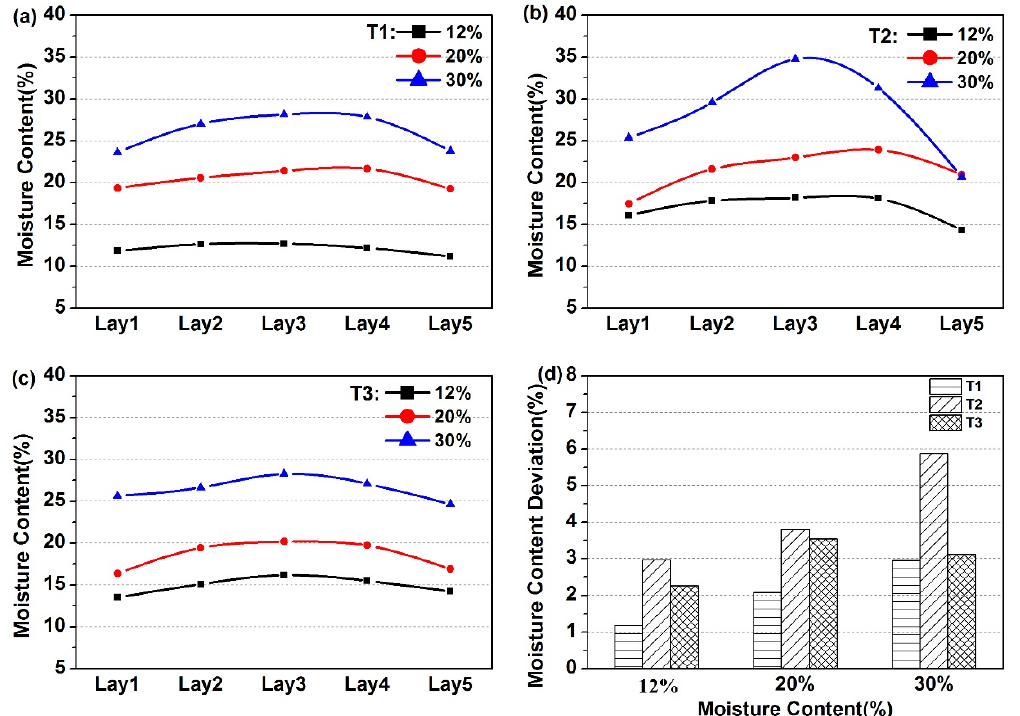
Figure 7. MC distribution of T1 ( a ), T2 ( b ), and T3 ( c ) in the thickness direction and MC deviation of T1, T2, and T3 ( d ) during drying. Lay 1–5 corresponds to MC section 1–5 in Figure 2.